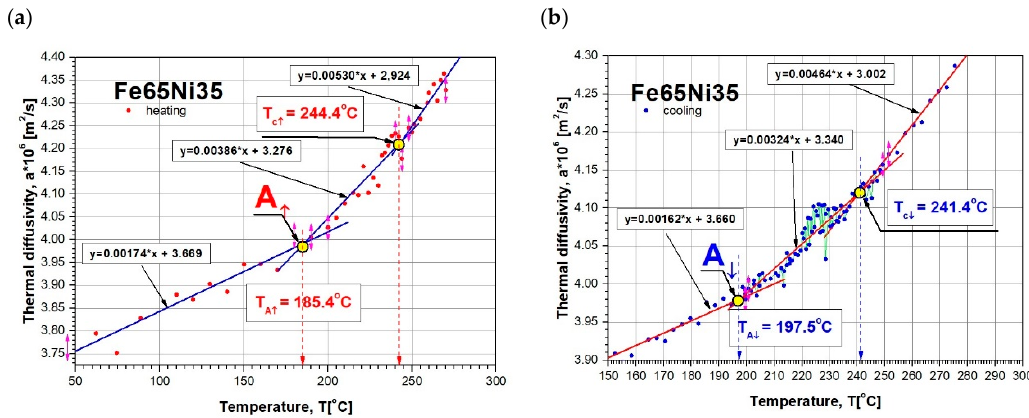
Figure 10. Example of T C temperature determination as the point of linear-regression-line intersection of Fe65Ni35 thermal-diffusivity changes during ( a ) heating and ( b ) cooling.